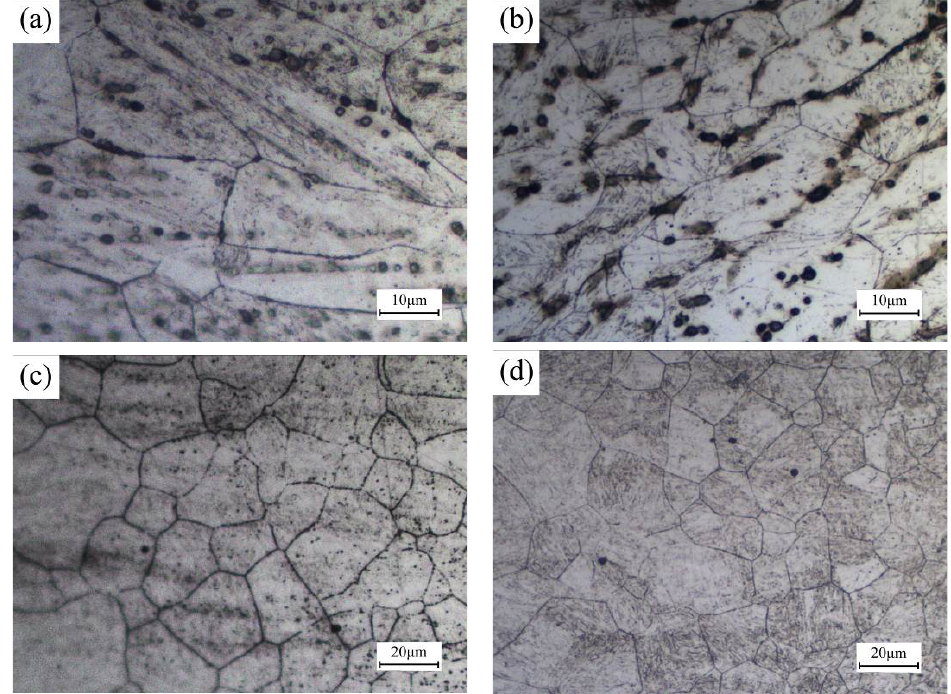
Figure 9. Grain morphology of FZ ( a ) welding speed 22 mm/s; ( b ) welding speed 40 mm/s and grain morphology of CGZ ( c ) welding speed 22 mm/s; ( d ) welding speed 40 mm/s.